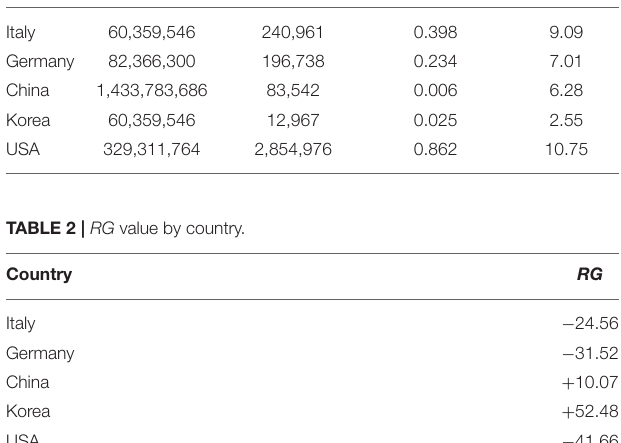
TABLE 1 | Incidence by country and test rate. Country Population Covid-19 cases Incidence (%) Test rate (%)